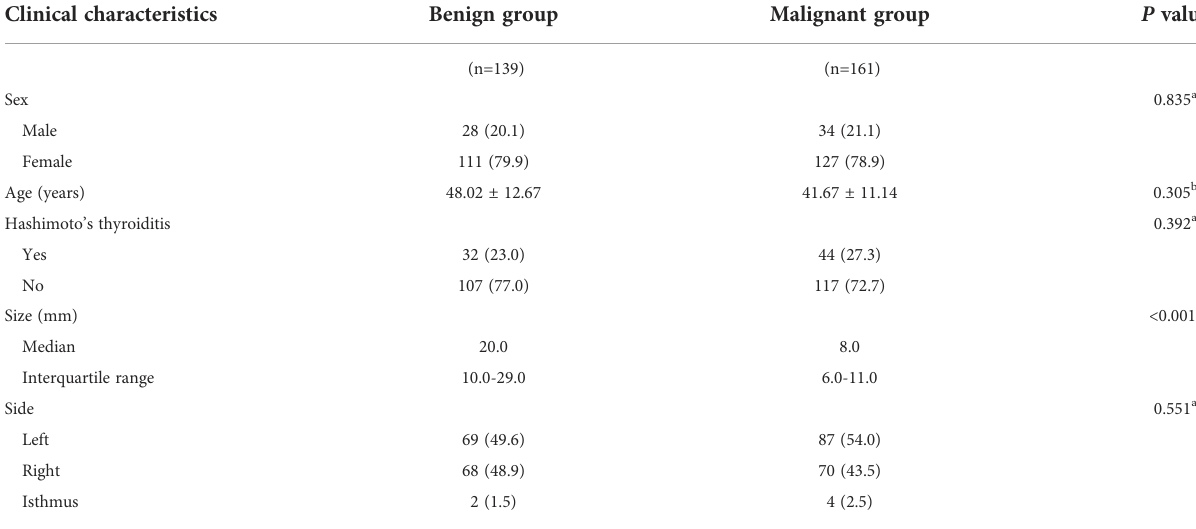
TABLE 2 Clinical characteristics of benign and malignant thyroid nodules in the training set.